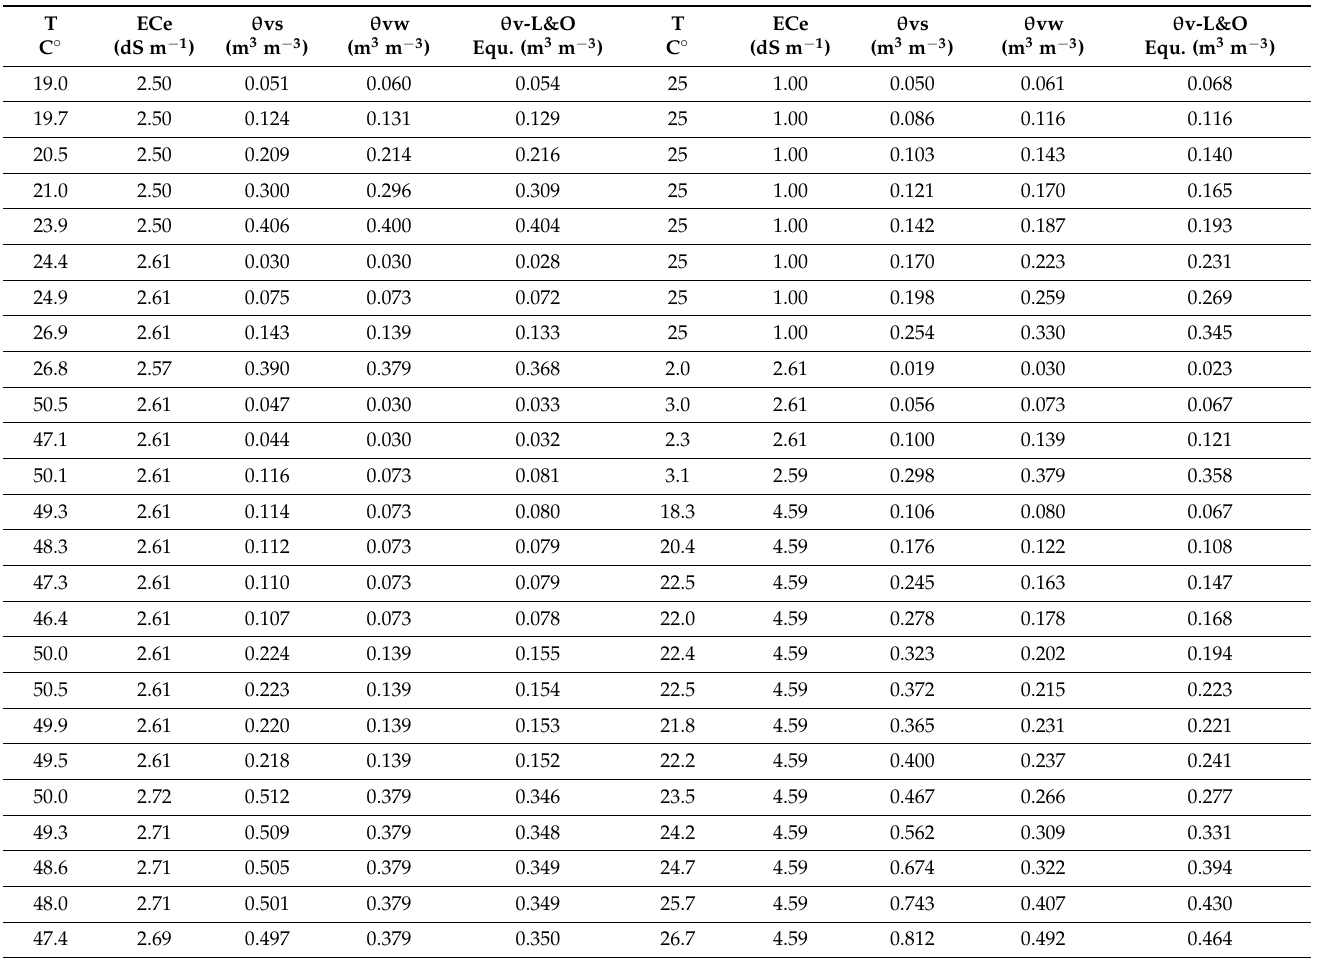
Table 7. Sensor measurement corrections using the proposed L&O correction equation under different soil salinity and temperatures (in loam soil